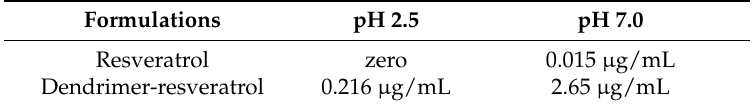
Table 1. Effect of pH on solubility of resveratrol and dendrimer-resveratrol